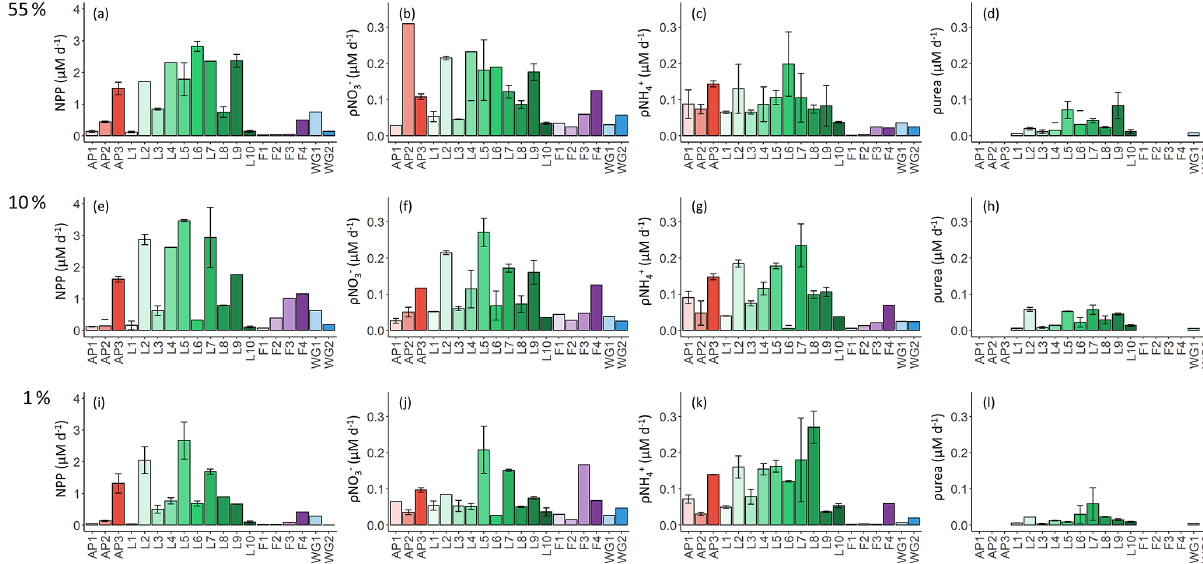
Figure 6. Daily rates of (a, e, i) NPP, (b, f, j) ρ NO 3 − , (c, g, k) ρ NH 4 + , and (d, h, l) ρ urea for the 55% (a–d) , 10% (e–h) , and 1% (i–l) light levels. Where there are no bars in panels (d) , (h) , and (l) , no data are available. The stations are labelled on the x axis, and the general station locations are indicated by the different colours: red shades – Antarctic Peninsula, green shades – Larsen C Ice Shelf, blue shades –Weddell Gyre, light purple shades – early-summer Fimbul Ice Shelf, and dark purple – late-summer Fimbul Ice Shelf. The error bars represent ± 1 SE of replicate experiments ( n = 2).